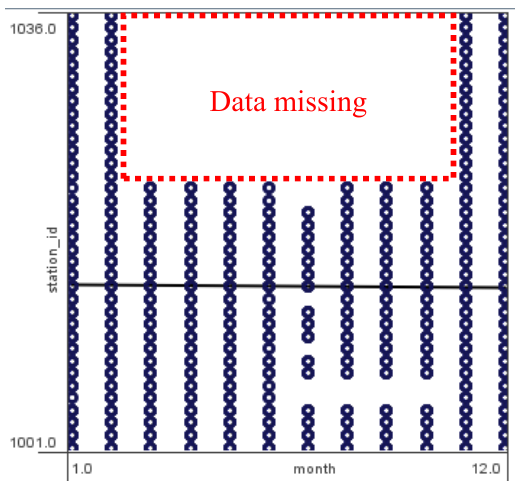
Figure A2. A scatterplot for 12 months and 36 stations.